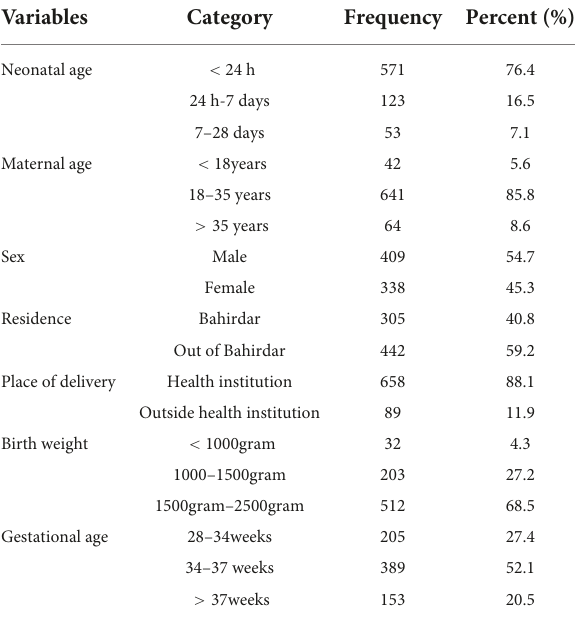
TABLE 1 Sociodemographic characteristics of mothers and neonates admitted to the neonatal intensive care unit (NICU) of Felege Hiwot Compressive Specialized Hospital (FHCSH), Ethiopia from 1 January 2015 to 30 December